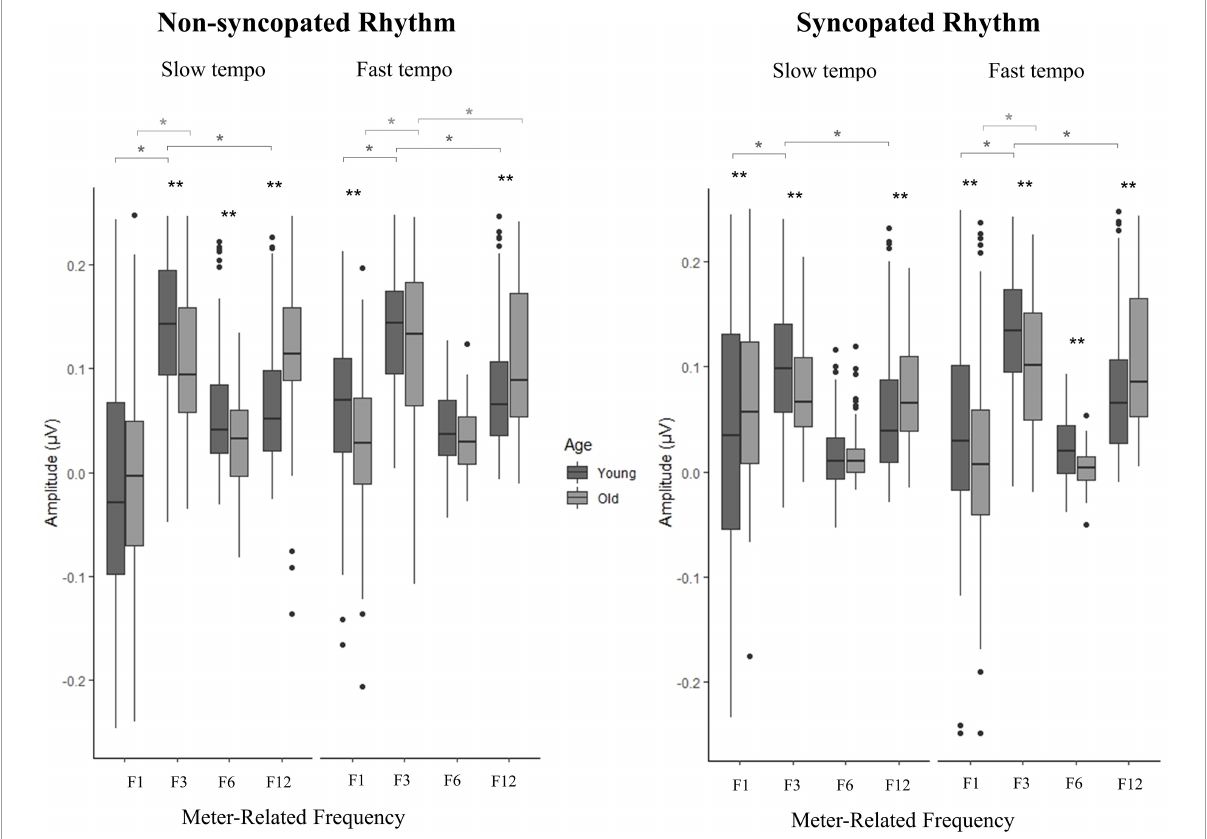
FIGURE8 Amplitude of neural activity at the different meter-related frequencies across the four conditions. Boxes represent the first quartile, median and third quartile of data, with points representing outliers; data represents amplitude values for each frequency (4 m-related frequencies), channel (12 channels) and participant. ** p < 0.003 (Bonferroni corrected) for all age comparisons. * p < 0.006 (Bonferroni corrected) for all frequency